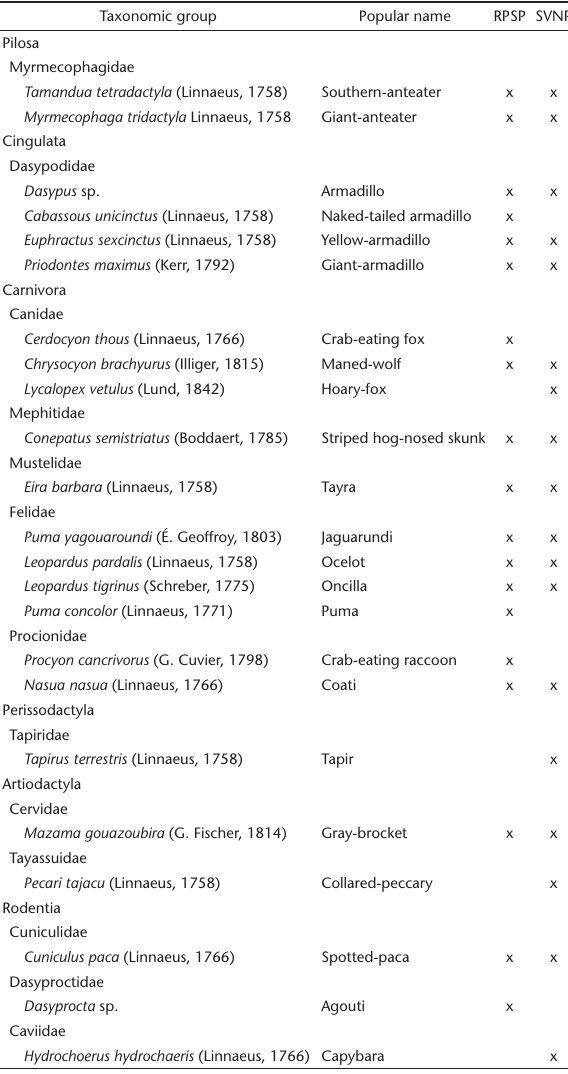
Table 1. Mammal species recorded at Rio Preto State Park (RPSP) and Sempre Vivas National Park